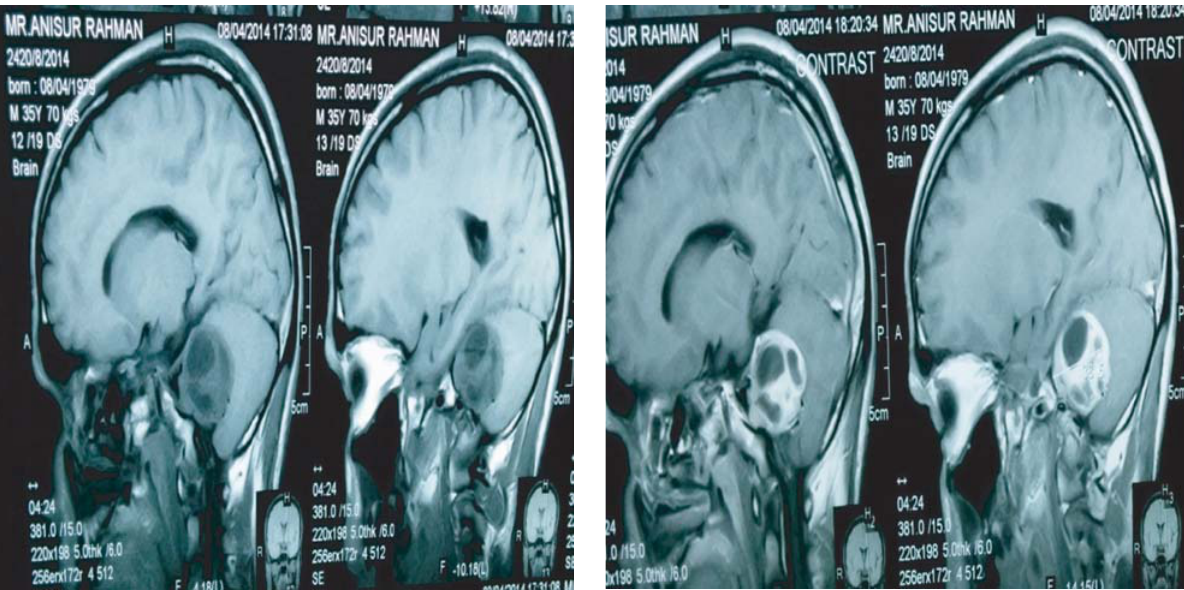
Fig 1. Pre- and post-contrast MRI shows well defined, enhancing, large heterogeneous and cystic mass in left cerebello-pontine (CP) angle suggesting acoustic schwannoma